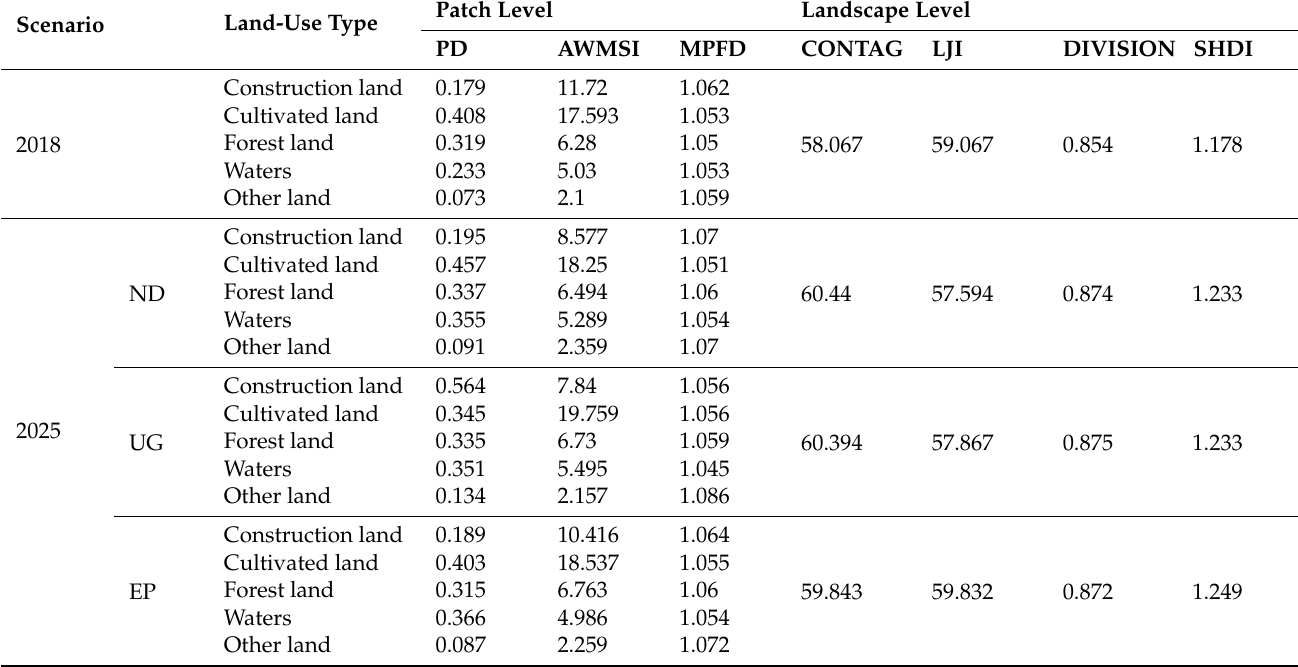
Table 4. Comparison of landscape pattern indexes in the study area between 2018 and